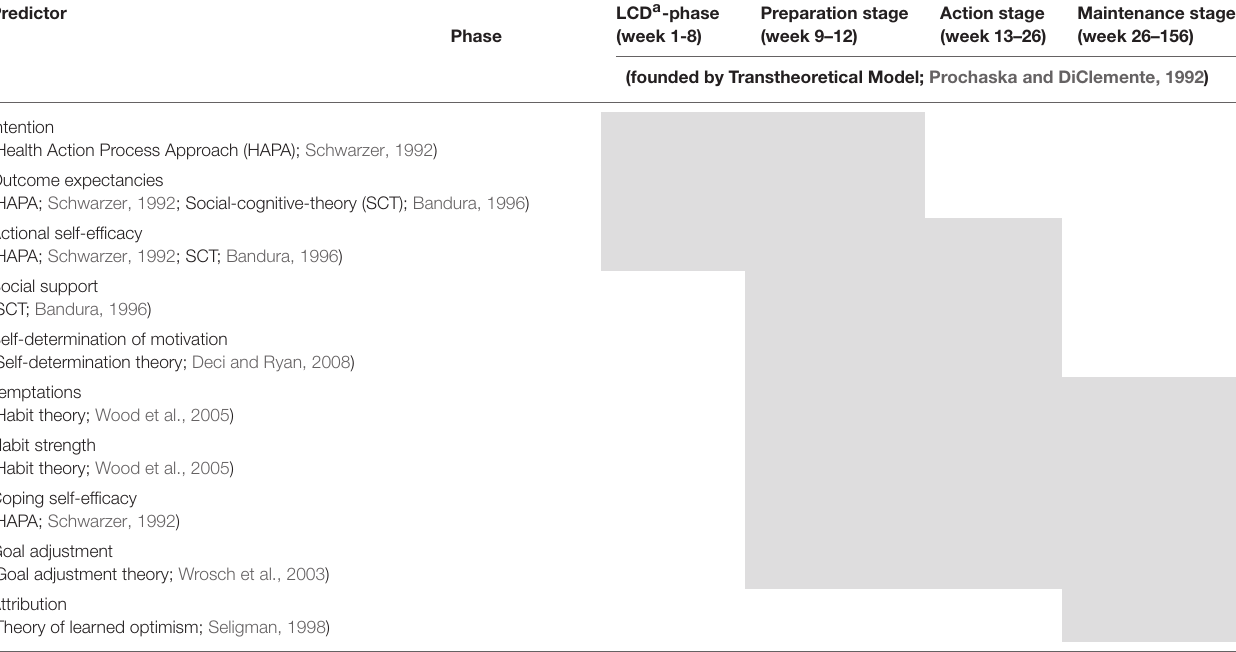
TABLE 1 | Predictors and stages of behavior modification in PREMIT as well as their source of reference in brackets.